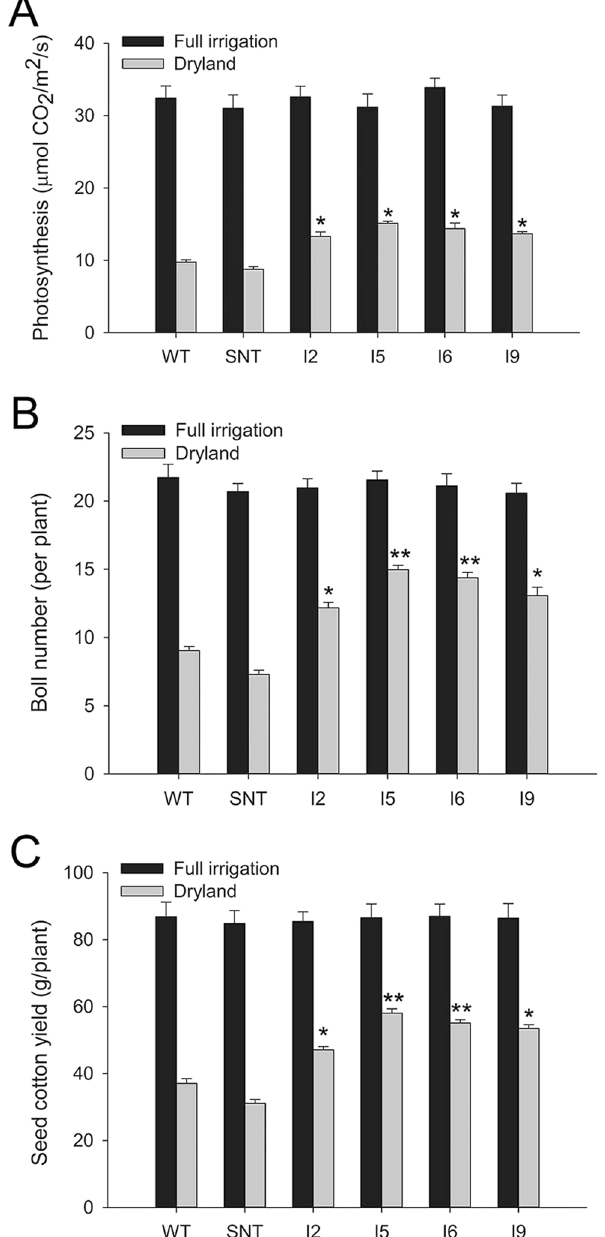
Figure 1. Photosynthetic rate, boll number, and seed cotton yield of cotton lines under full irrigation and dryland conditions in 2010. WT, wild-type cotton (Coker 312); SNT, segregated non-transgenic cotton; IPT2 to IPT9, four independent IPT -transgenic cotton lines. Black bar, full irrigation condition; grey bar, dryland condition. * Statistically significant at the < 0.05 level; ** statistically significant at < 0.01